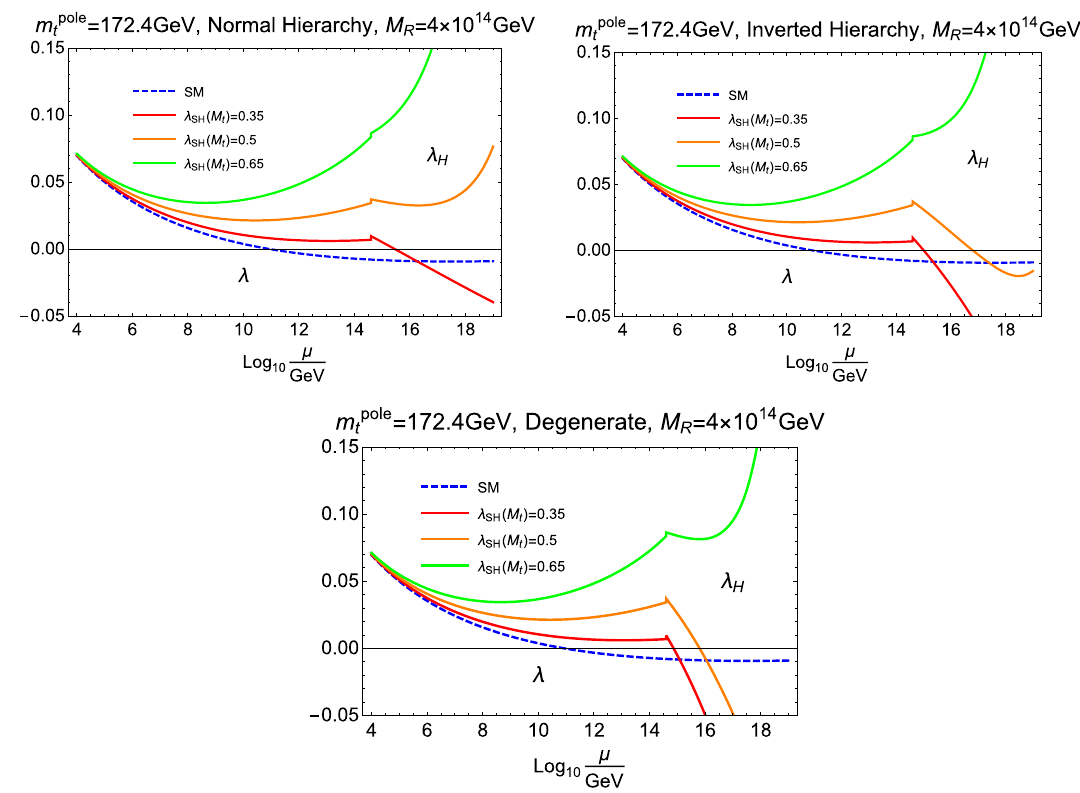
Fig. 3 The RG runnings of λ and λ H . Upper left (right) corresponds to the case of normal (inverted) hierarchy and lower panel corresponds to the degenerate case. Here, the different colors correspond to the different values of λ SH ( M t